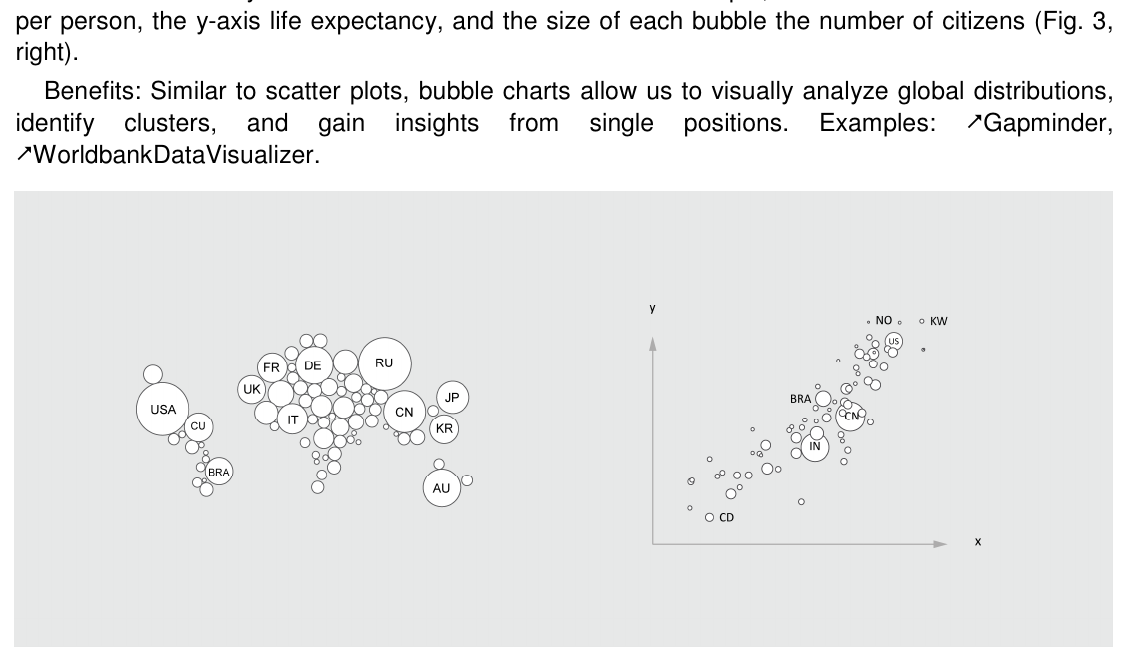
Figure 3: Examples of a cartogram (left) and a bubble chart (right), with the latter showing income per person (x-axis), life expectancy (y-axis), and number of citizens (bubble